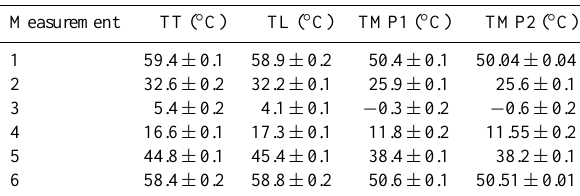
Table 10. Temperature registers and their temporal variation.